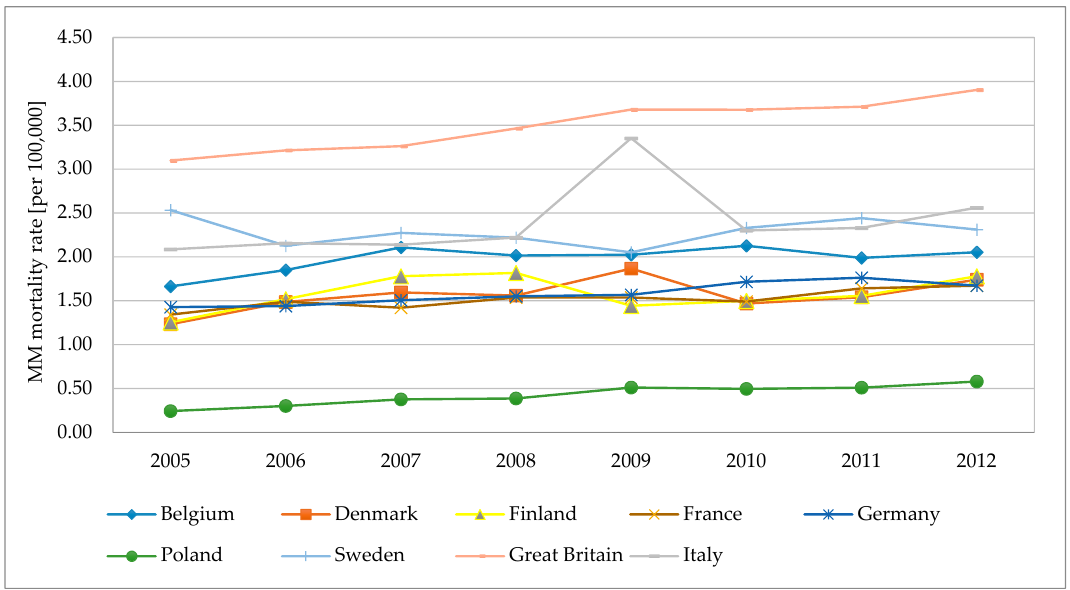
Figure 8. MM annual mortality rates in selected European countries in 2005–2012.